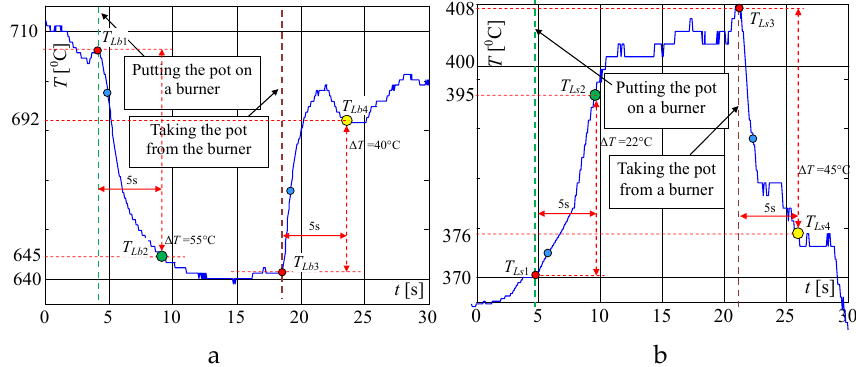
Figure 15. Extended characteristics measured by the linear thermocouple in position 1 (Figure 11) if putting the pot on and removing it from the burner when the flame is: ( a ) big, ( b ) small; explanation: red circles—start points for big flame T Lb 1 and T Lb 3 and for small flame T Ls 1 and T Ls 3 ; blue circle—recognition of temperature changes, green circle—recognition that the pot is placed on the burner T Lb 2 and T Ls 2 ; yellow circle—recognition that the pot is taken from the burner T Lb 4 and T Ls 4.